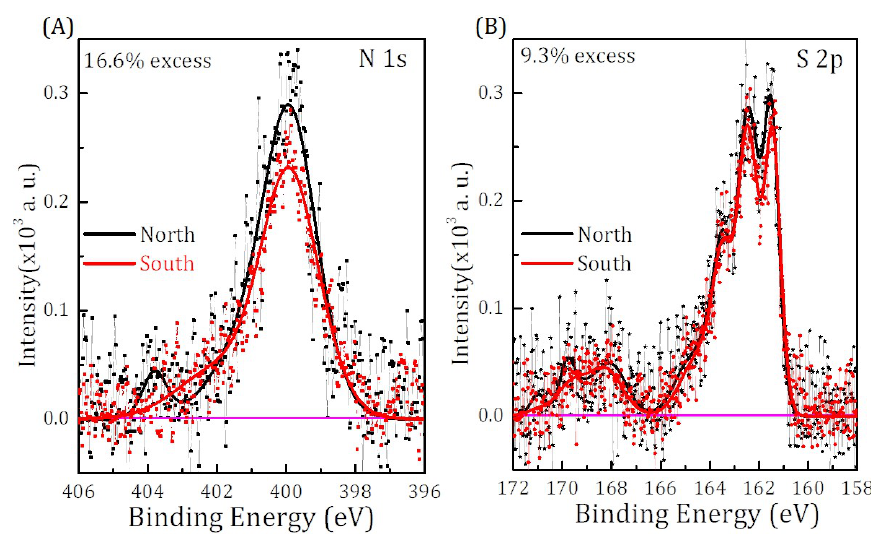
Figure 4. XPS spectra recorded on L-cysteine monolayer, where ( A ) nitrogen- N 1 s with north up (black) and south up (red), similarly ( B ) for sulfur- S 2 p